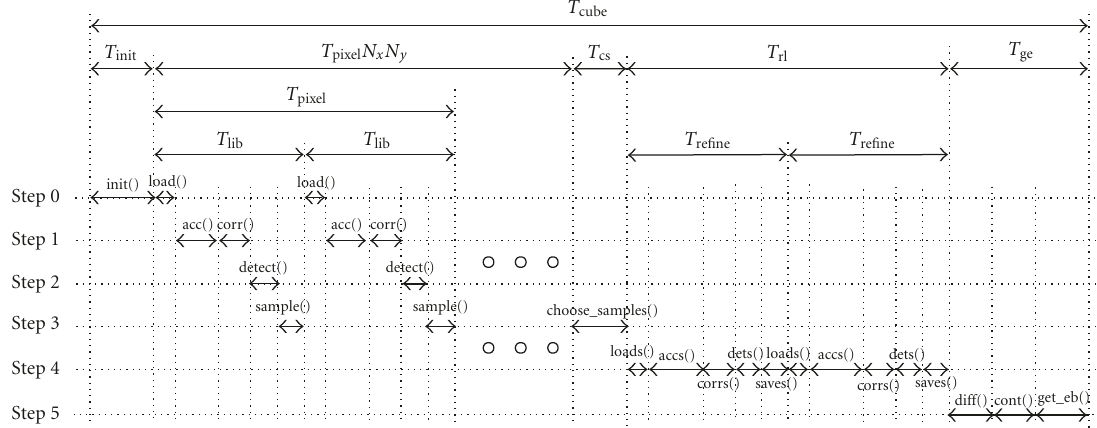
Figure 4: Timing flow in the processing where N LIB = 2.